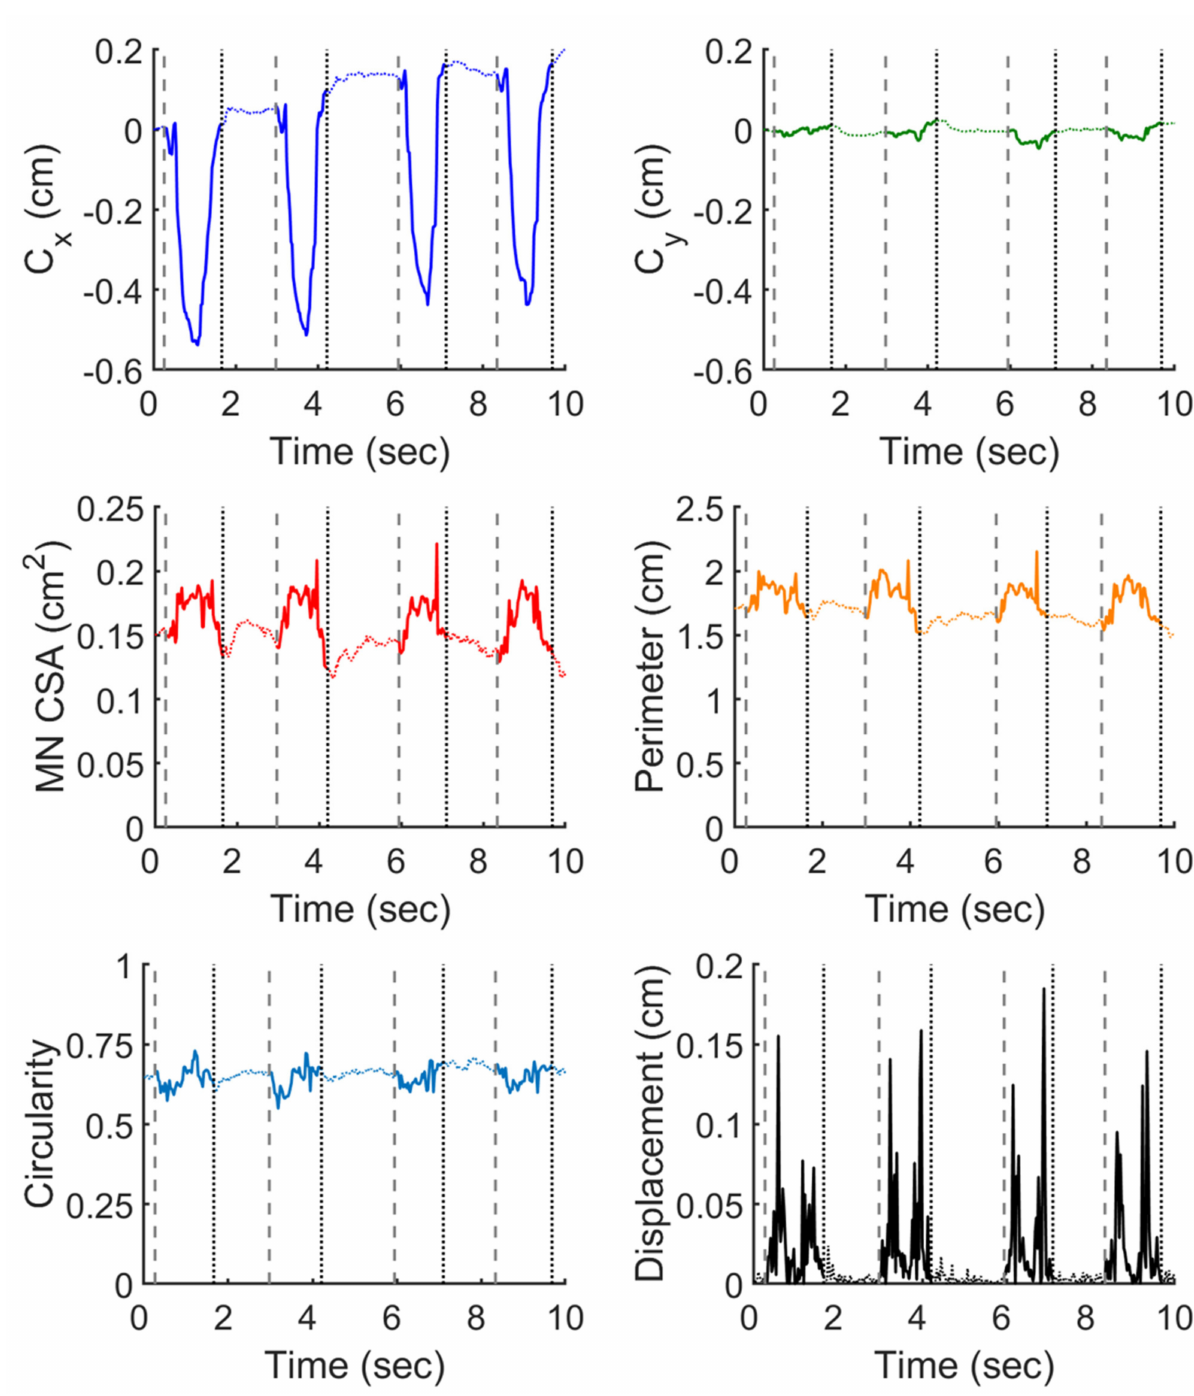
Figure 2. Typical temporal profiles of the morphological characteristics of an inferred median nerve (MN) during fingers motion, including the x ( C x) and y ( C y) coordinates of the MN centroid, the cross-sectional area (CSA) and the perimeter of the MN, the MN circularity, and the centroid displacement between consecutive images. The data were grouped by four cycles of finger flexion and extension, with that the vertical gray dash lines represent the beginning of each cycle and the black dotted lines denote the end of the cycle. Data collected within and out of individual cycles were depicted in solid and dotted line,